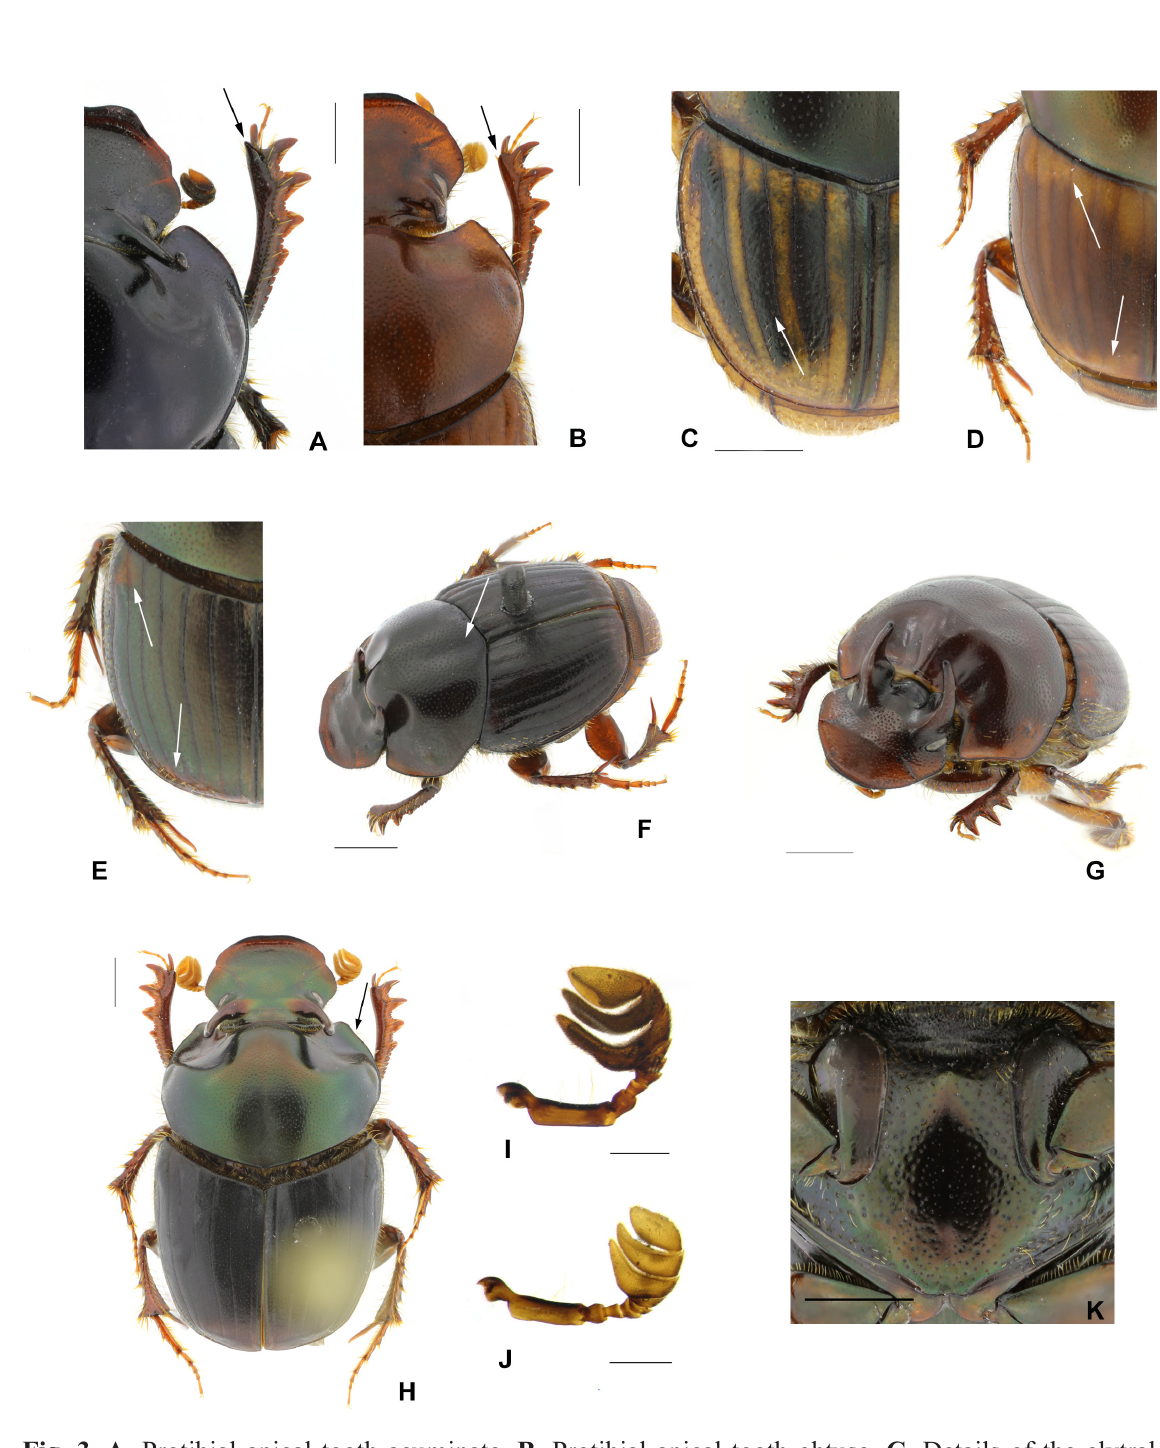
Fig. 3. A . Protibial apical tooth acuminate. B . Protibial apical tooth obtuse. C . Details of the elytral interstriae of Onthophagus marginicollis Harold, 1880 ( hircus complex). D–E . Detail of the elytral paler spots. F . Pronotal sulcus of O. haematopus Harold, 1875 ( rubrescens complex). G . Detail of the basal carina of the cephalic horns. H . Shape of the clypeus and lateral margin of pronotum of a species of the ophion complex. I . Right antenna of species of the ophion complex. J . Right antenna of species of the osculatii complex. K . Detail of the metasternal punctuation of a species of the osculatii complex. Scale bars: 1